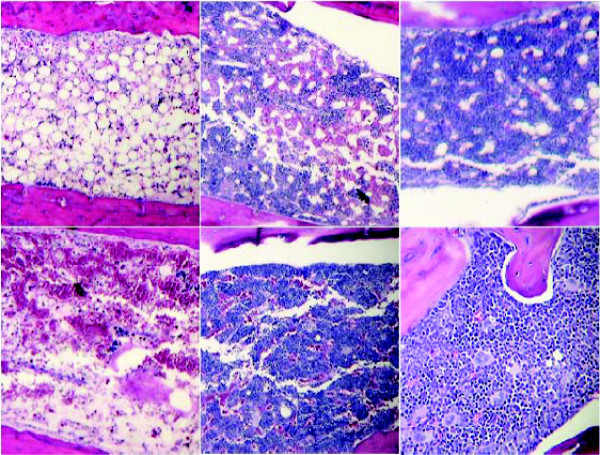
Pathology of bone marrow for the vehicle, G-CSF, IL-12 pre-only, IL-12 post-only and IL-12 pre-post treatment groups following radiation. Bone marrow specimens for the EL4 lymphoma model (top) and the Lewis lung cancer model (bottom) are shown. For the EL4 model, vehicle (top, left), G-CSF (top, middle) and IL-12 pre-post (top, right) are shown. For the Lewis lung cancer model (bottom), vehicle (bottom, left) and IL-12 pre-only (bottom, middle) are shown. No G-CSF treated mice survived the second radiation dose. A normal (untreated) control bone marrow specimen is also shown (bottom, right).